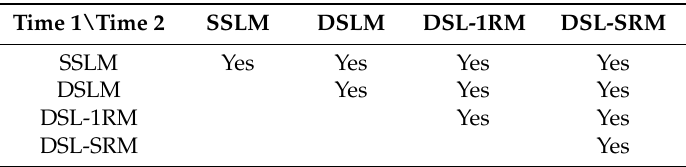
Table 1. Types of spatial relations between SGRPMs.